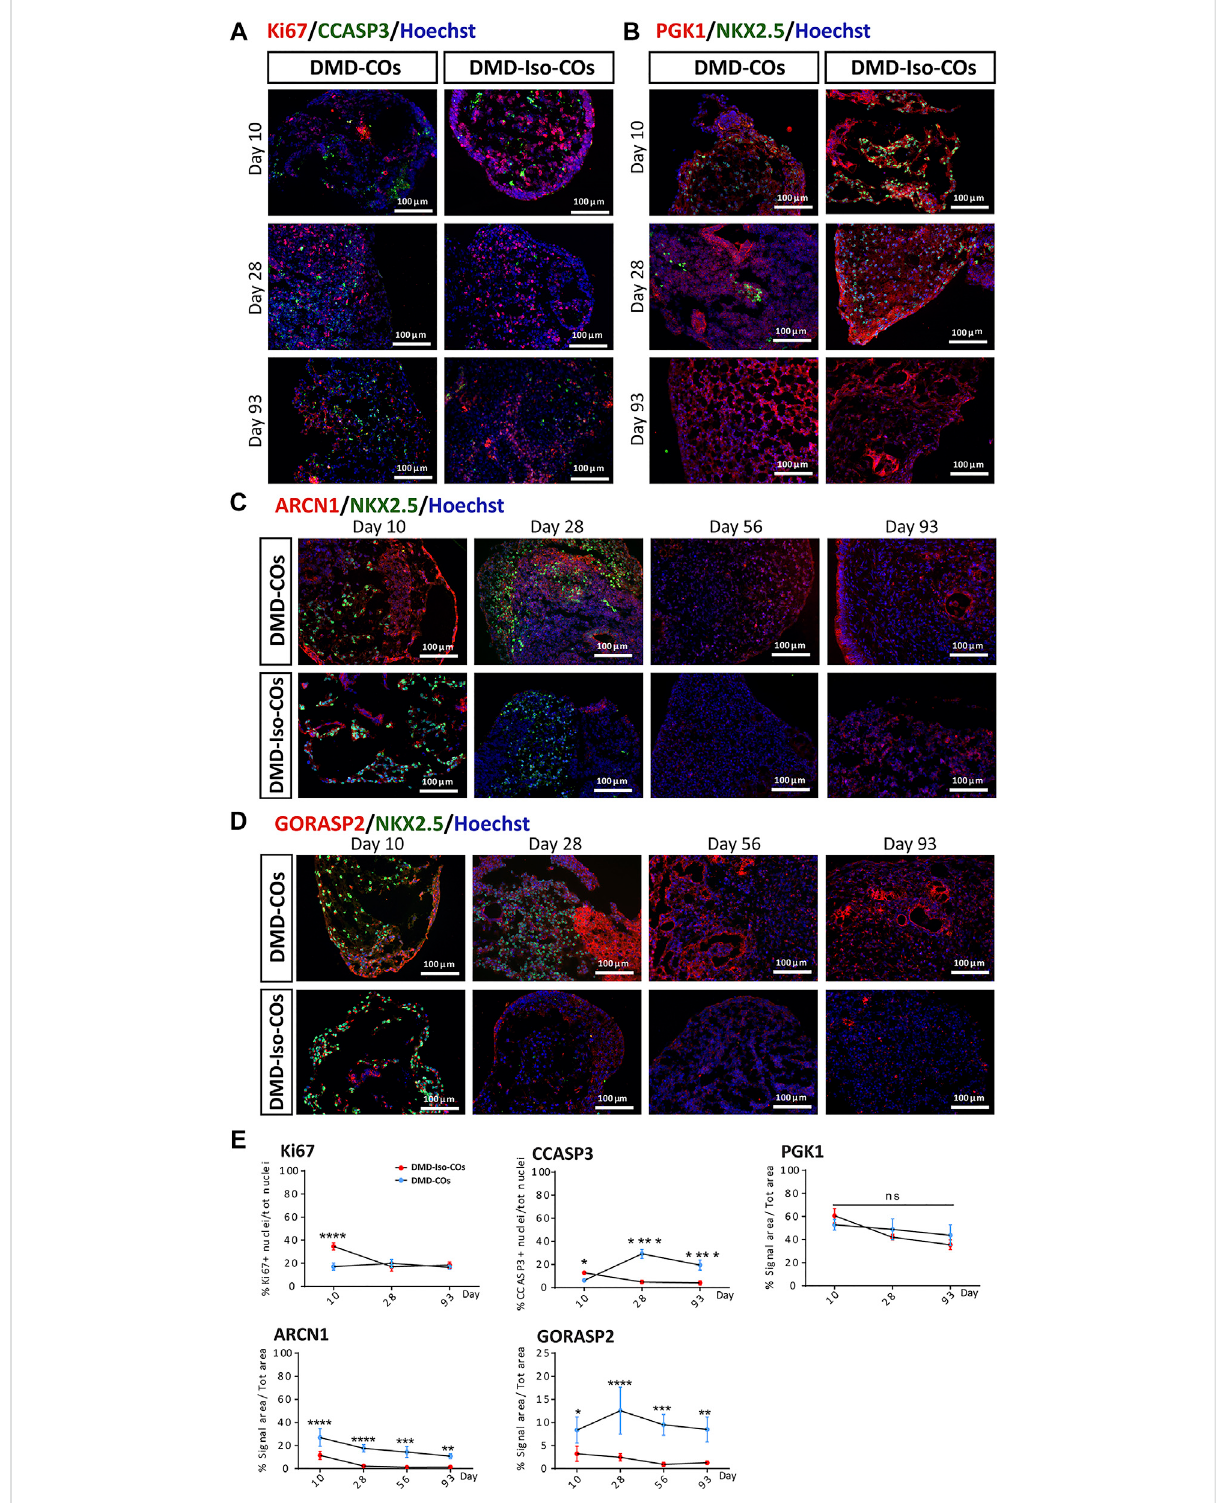
FIGURE 4 Assessment of cell proliferation, apoptosis and ER stress in DMD-COs and DMD-Iso-COs over 93 days of dynamic culture. Representative immuno fl uorescence images for: (A) Ki67/CCASP3, (B) PGK1/NKX2.5 on day 10, 28 and 93; (C) ARCN1/NKX2.5 and (D) GORASP2/NKX2.5 on day 10, 28, 56 and 93. Nuclei were counterstained with Hoechst. Data are representative of three independent experiments ( n = 3). (Magni fi cation: ×20). (E) Quanti fi cation of the immuno fl uorescence images for: Ki67, CCASP3 and PGK1 on day 10, 28 and 93; ARCN1 and GORASP2 on day 10, 28, 56and93.Datashownaremean±s.d.( n =4,two-wayANOVAwithSidak ’ smultiplecomparisons:* p < 0.05,** p < 0.01,*** p < 0.001,**** p <